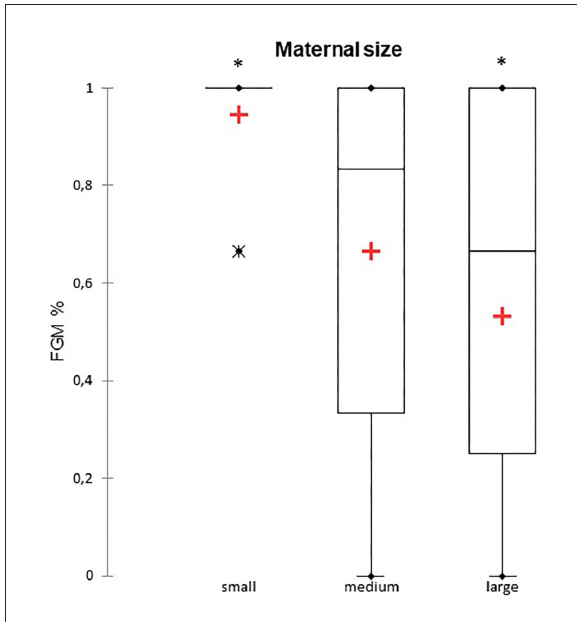
FIGURE2 The box plot reports the percentage of fetuses showing fetal gastrointestinal motility (FGM%) in relation to maternal size in small ( ≤ 10kg), medium (11–25kg), and large size ( ≥ 26kg) bitches (10–12). Asterisk (*) indicates a statistically significant difference between classes ( P = 0.01). The mean is indicated as a red cross ( + ).